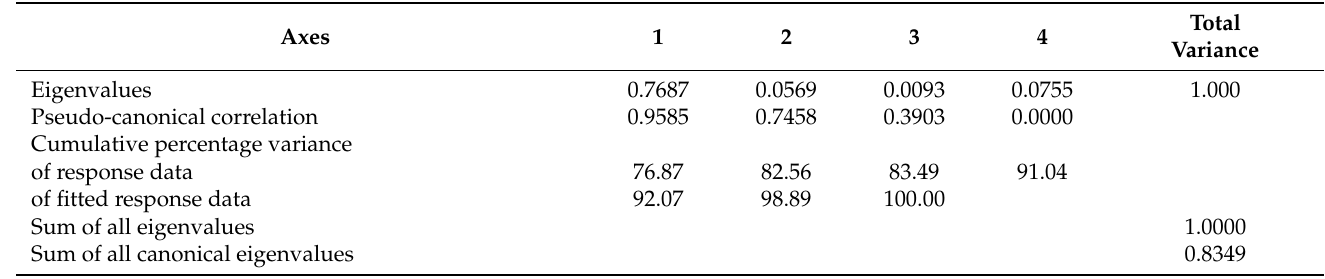
Table 4. Summary statistics for RDA of anglers’ reactions and behavior and perceived positive effects of angling on COVID-19 pandemic stress reduction (response data) versus selected socio-demographic factors (explanatory variables, VIF * <